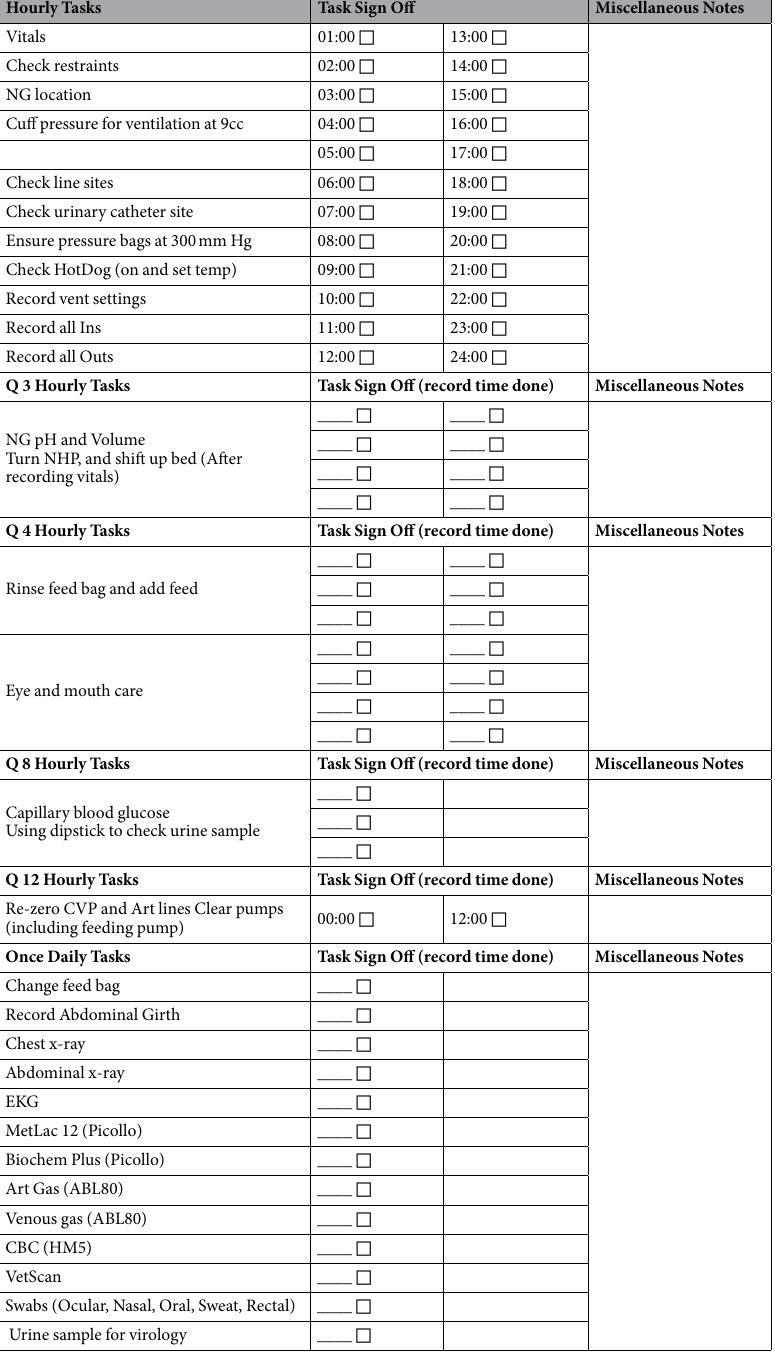
Table 2. Bedside Team Task